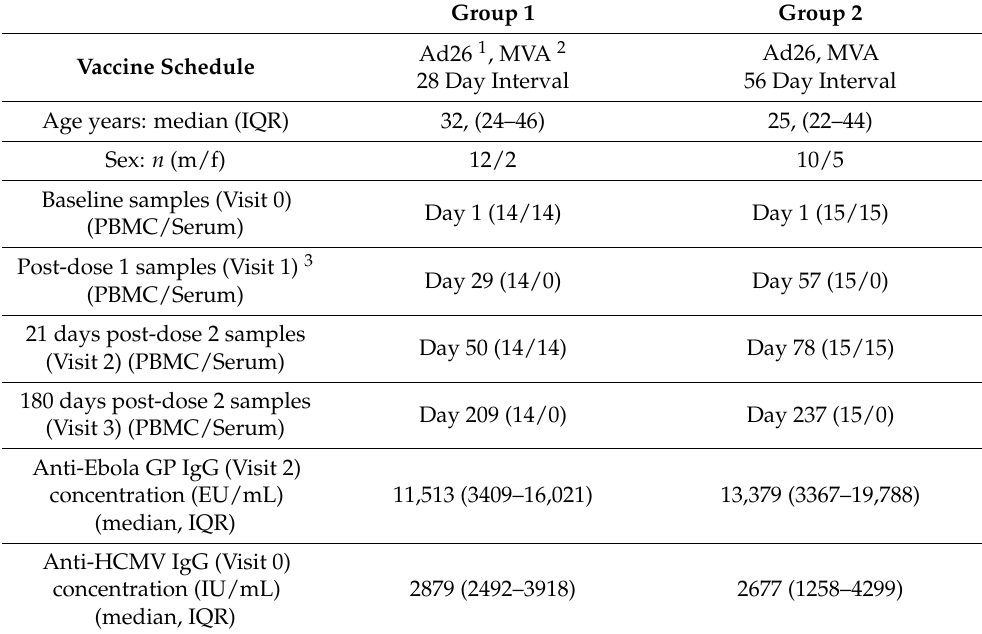
Table 1. Randomised vaccination regimen and corresponding numbers of serum and PBMC samples used in this